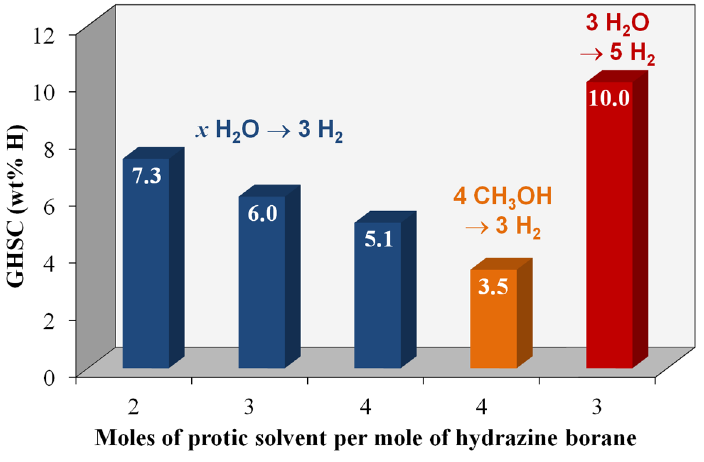
Figure 3. Theoretical gravimetric hydrogen storage capacity (denoted GHSC, in w t % H) for the couples N 2 H 4 BH 3 - x H 2 O (with x equal to 2, 3 and 4) and N 2 H 4 BH 3 -4CH 3 OH. In blue and orange, the BH 3 group hydrolyzes only into 3 moles of H 2 (Equations (7)–(10)). In